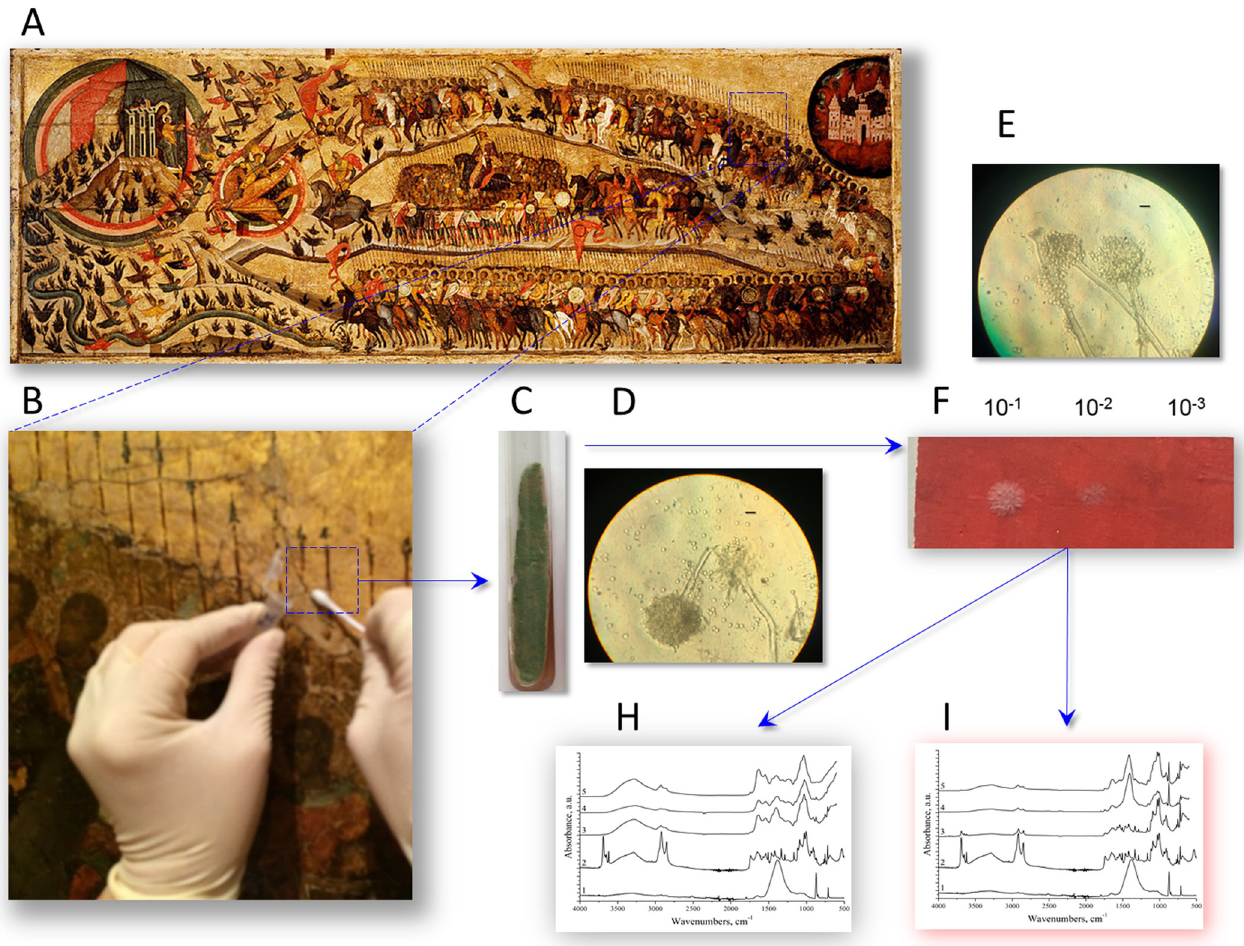
Fig 4. Analysis of biodeterioration in tempera paintings. (A) Icon “The Church Militant” (object I). (B) Collection of sample 25 from the crack of object I. (C) Sample cultivation on slant CD agar. (D and E) Light microscopy images of sample 25 growth on CD agar (D) and on the surface of mock layer 15 (E); scale bar = 10 μ m. (F) Drop and dilution assay for inoculum 25G growth on mock layer 15 (48 h at 25˚C). (H and I) Micro-FTIR spectroscopy analysis of biodeterioration in mock layer 15 before (H) and after (I) removal of the 25G-produced microbial sheet. FTIR spectra: 1 –intact levkas, 2 –intact mock layer 15, 3 –periphery of the inoculated zone; 4 –areola zone; 5 –center of the inoculated